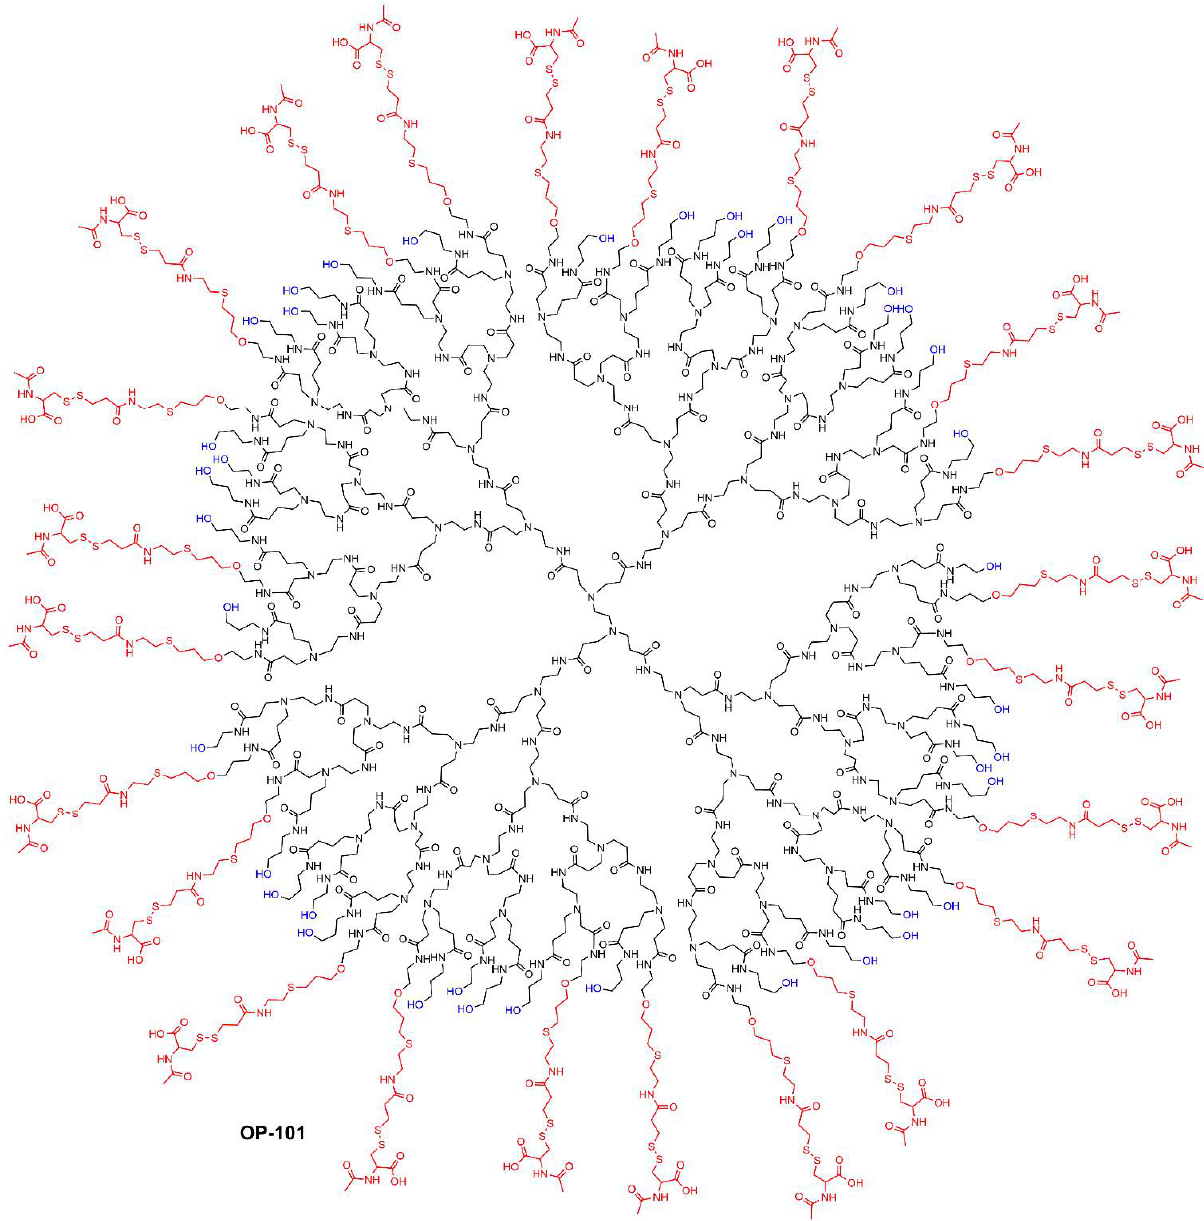
Figure 5. Hydroxyl generation 4 PAMAM dendrimers stochastically functionalized; one of the possible full structure of OP-101.